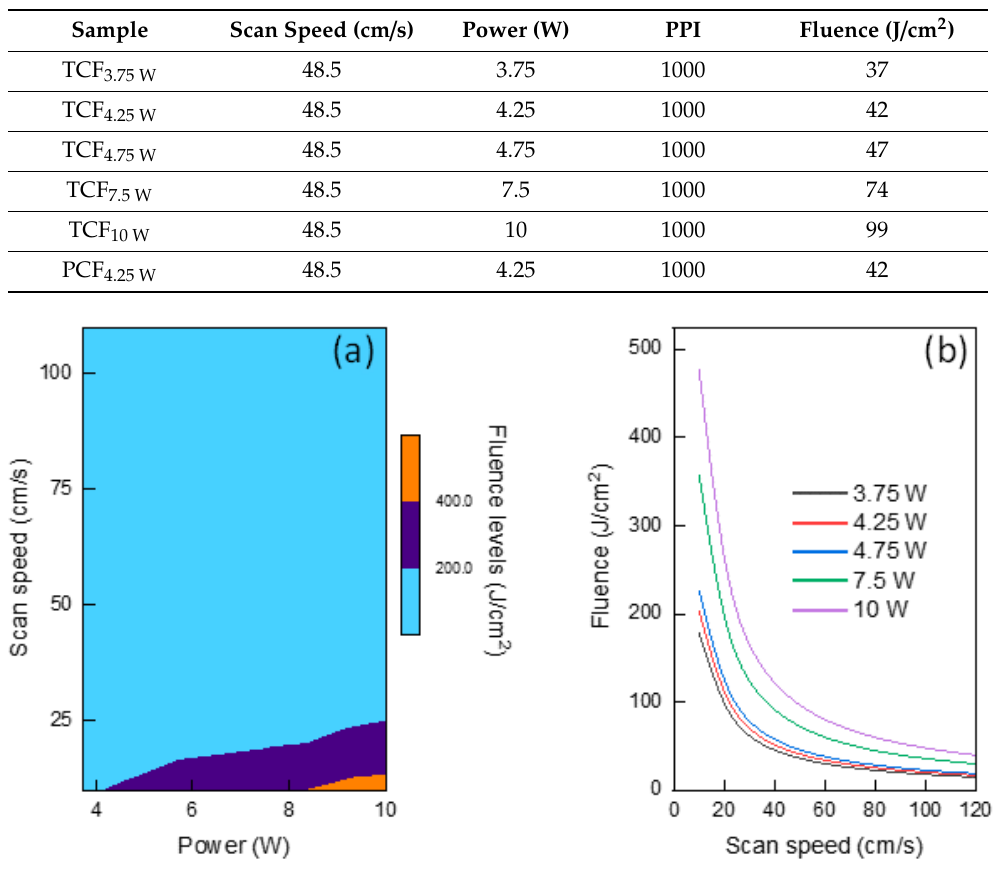
Table 1. Fluence calculation of all irradiated samples.